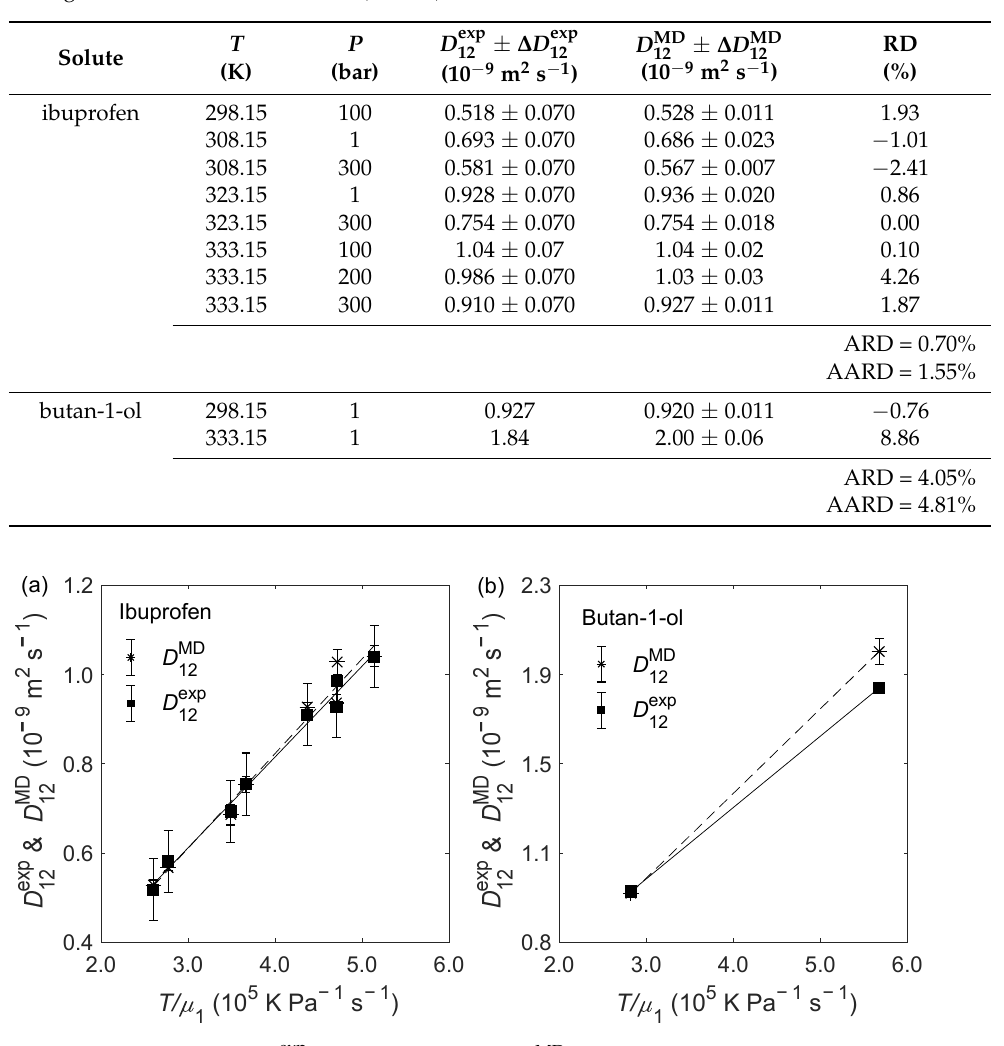
Figure 3. Experimental ( D exp , (cid:4) ) and computed ( D MD , *) diffusion coefficients in liquid ethanol versus Stokes–Einstein abscissae ( T / µ 1 ) for ( a ) ibuprofen and ( b ) butan-1-ol. The viscosity values were estimated by the Mamedov equation, as proposed by Cano-Gómez et al. [44] .